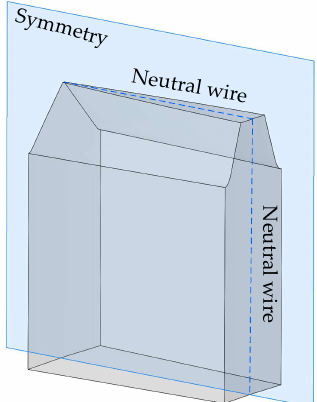
Figure 3. Symmetry of the face gear tooth surface.